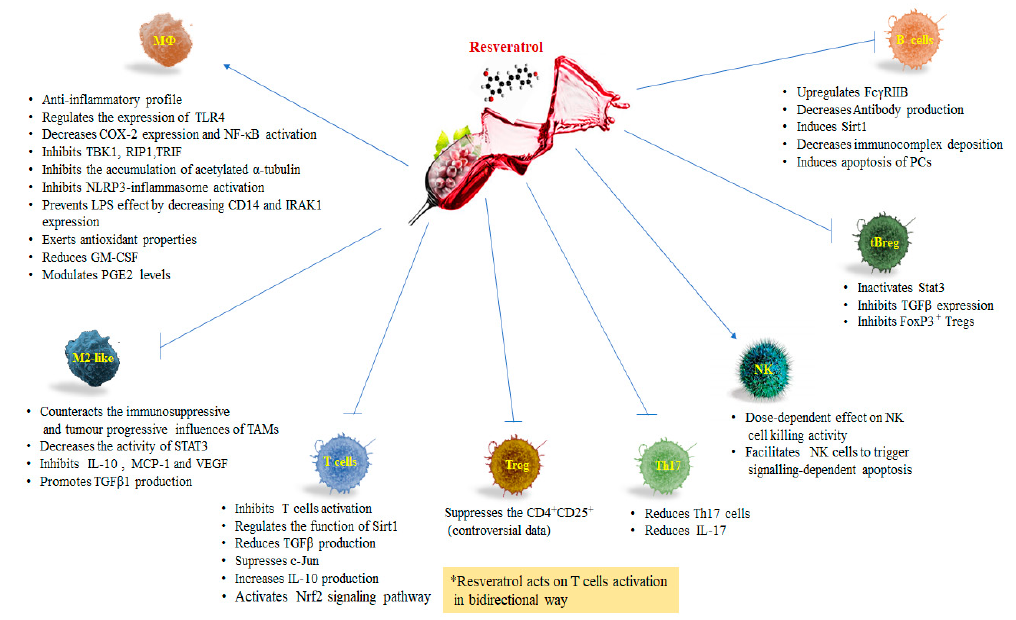
Figure 3. E ff ects of resveratrol on immune cells: Breg, regulatory B cell; COX2, cyclooxygenase; FOXP3, forkhead box P-3; GM-CSF, granulocyte–macrophage colony-stimulating factor; IL-10, interleukin-10; IL-17, interleukin 17; IRAK, interleukin-1 receptor-associated kinase; LPS, lipopolysaccharide; M Φ , macrophage; MCP1, monocyte chemoattractant protein-1; NF- κ B, nuclear factor-Kappa B; NLRP3, nod-like receptor family, pyrin domain containing 3; Nrf2, nuclear factor erythroid 2-related factor 2; RIP, receptor-interacting protein; PCs, plasma cells; PGE2, prostaglandin E2; Sirt1, silent mating type information regulation 2 homolog; STAT3, signal transducer and activator of transcription; TAMs, tumor associated macrophages; TBK1, TANK-binding kinase1; TGF- β 1, transforming growth factor- β 1; Treg, regulatory T cell; Th17, T helper 17; TRIF, toll-interleukin-1 receptor domain-containing adaptor inducing interferon; TLR-2, toll-like receptor-2; VEGF, vascular endothelial growth factor.